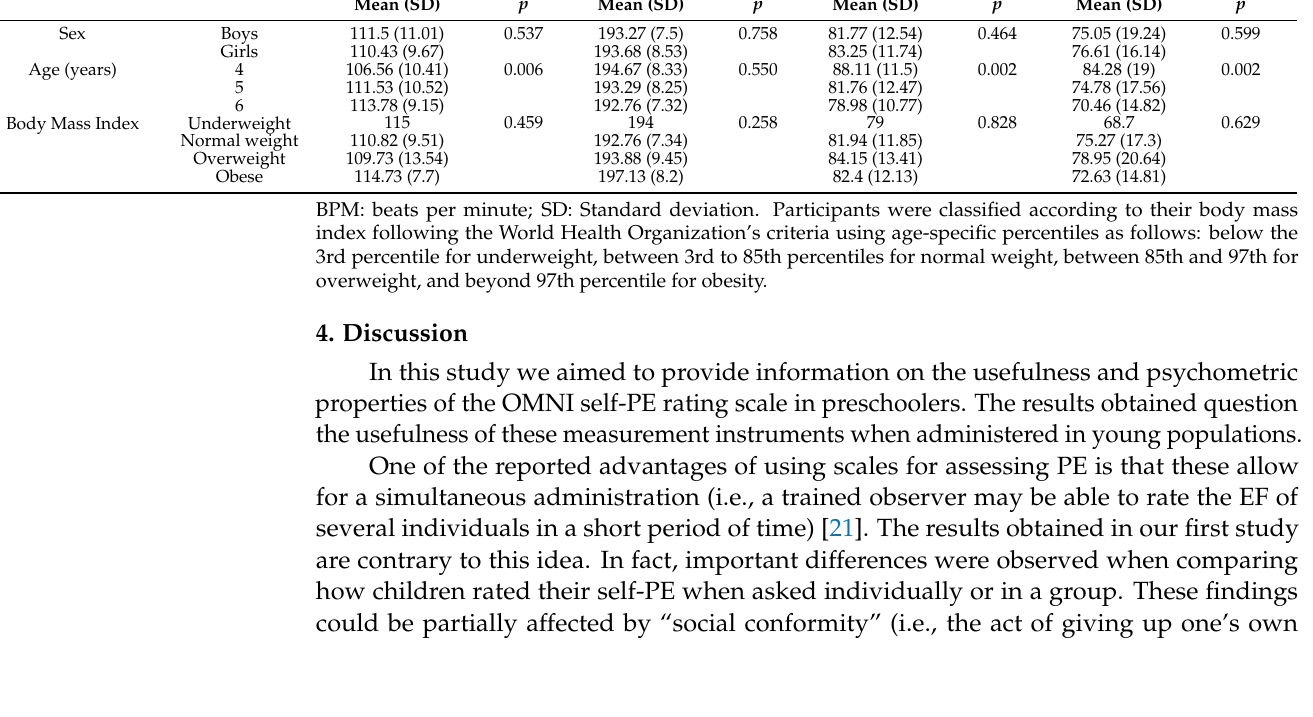
Table 3. Heart rate results across sex, age, and body mass index strata. Resting